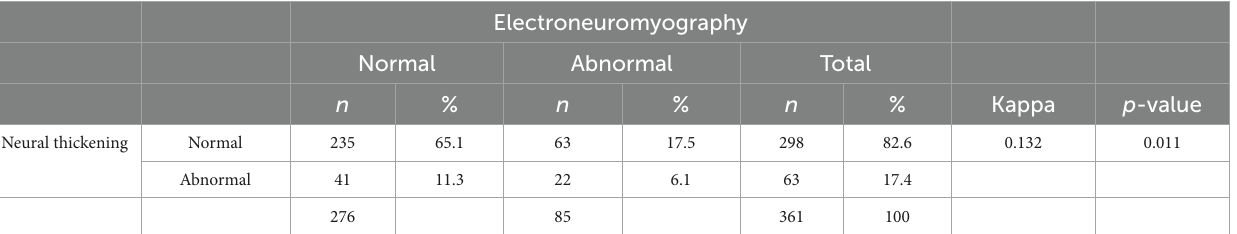
TABLE 5 Comparison between clinical examination for detection of neural thickening and electroneuromyographic evaluation of seropositive household contacts of leprosy patients.